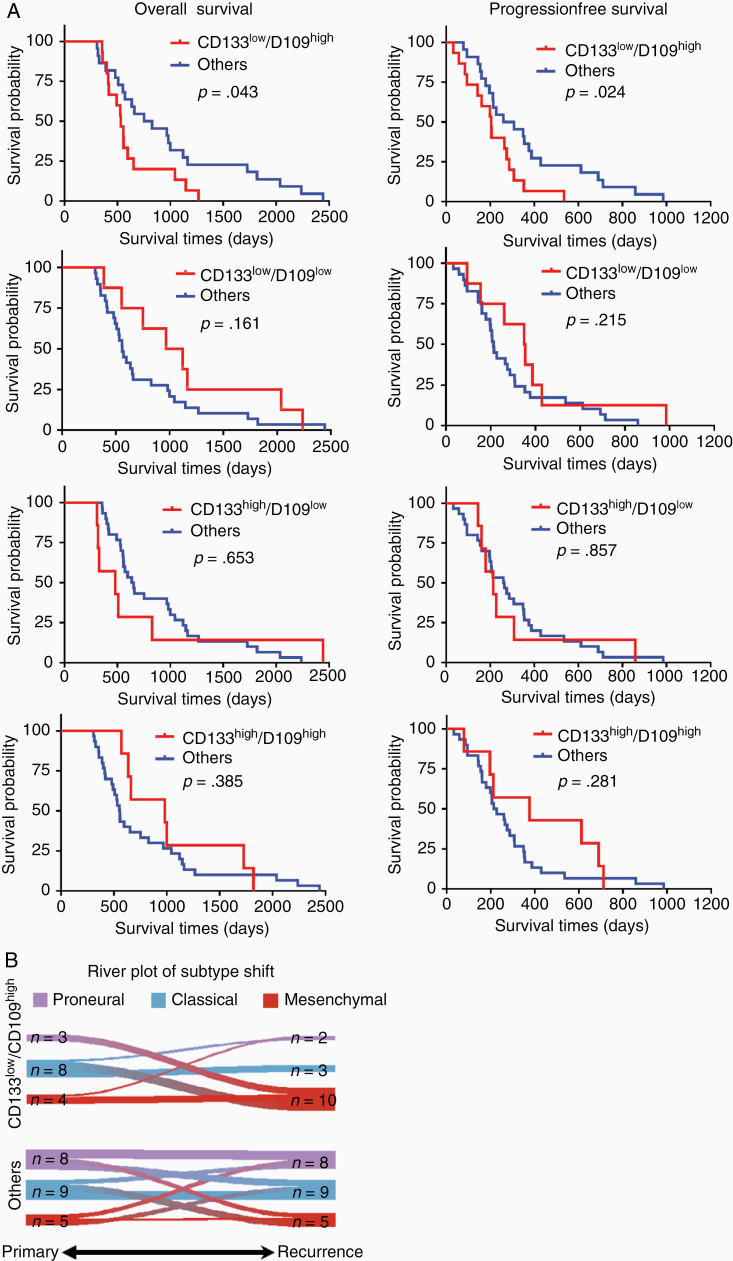
CD133low/CD109high group exhibits worse prognoses accompanied by an increase in mesenchymal signature. (A) Kaplan–Meier analysis of overall survival (left) and progression-free survival (right) of glioblastoma patients in CD133low/CD109low, CD133high/CD109low, CD133high/CD109high, and CD133low/CD109high (red, top to bottom) with each collected remaining cases (Others, blue). (Log-rank test). (B) River-plot analysis of the molecular subtype shifts from primary to recurrence in CD133low/CD109high (upper) and others (lower) (P = .028, chi-square test).